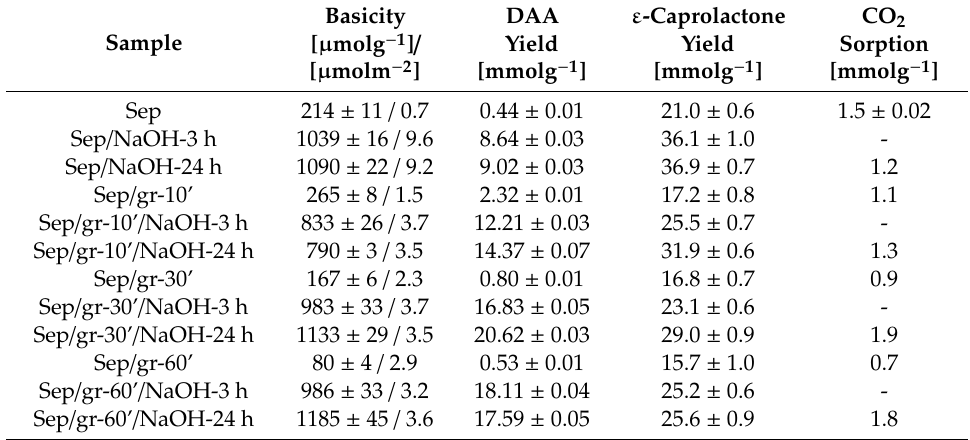
Table 4. Total basicity from benzoic acid titration, yield of DAA obtained in self-condensation of acetone, yield of ε -caprolactone in Baeyer-Villiger oxidation of cyclohexanone, and amount of sorbed CO 2 . Standard error of the mean value in